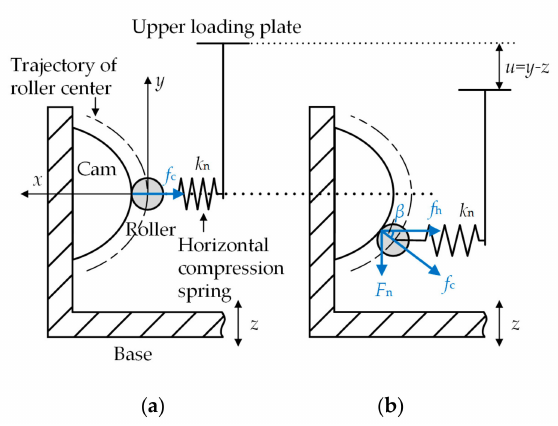
Figure 3. Static analysis of cam-roller mechanism with a quadratic polynomial trajectory (QCRM). ( a ) Roller at static equilibrium position; ( b ) roller deviating from equilibrium